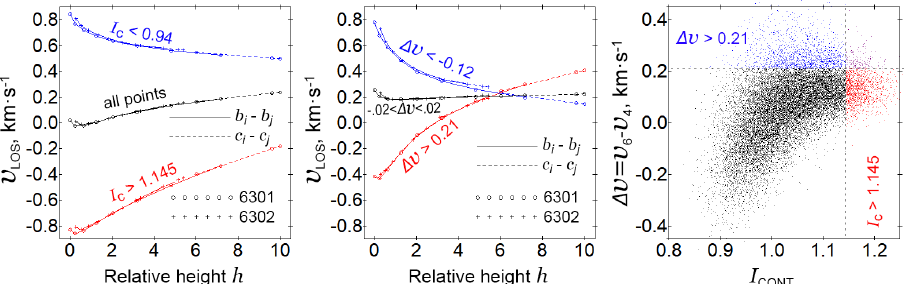
Figure 10. Absolute LOS velocities for statistical collections of map points, filtered by specified conditions. A gravitational shift of 635 m·s −1 and a shift associated with the rotation of the Sun of −340 m·s −1 are taken into account. All 6302 velocities are shifted to the blue at 260 m·s −1 . Left: LOS velocities for all points in 8 maps and for hottest and coldest populations. Center: LOS velocities for the upflow points with maximum deceleration, for the downflow points with maximum acceleration, and for cells that move without acceleration. Acceleration ∆v is measured as the difference in 6301 LOS velocities for levels b 6 and b 4 . Right: Scatter plot that explains why curves for upflow points I 1.145 and ∆v > 0.21 are